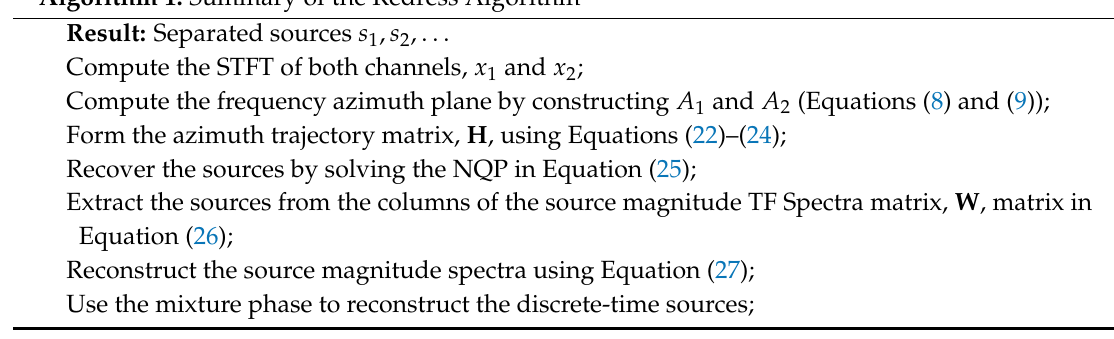
Algorithm 1: Summary of the Redress Algorithm